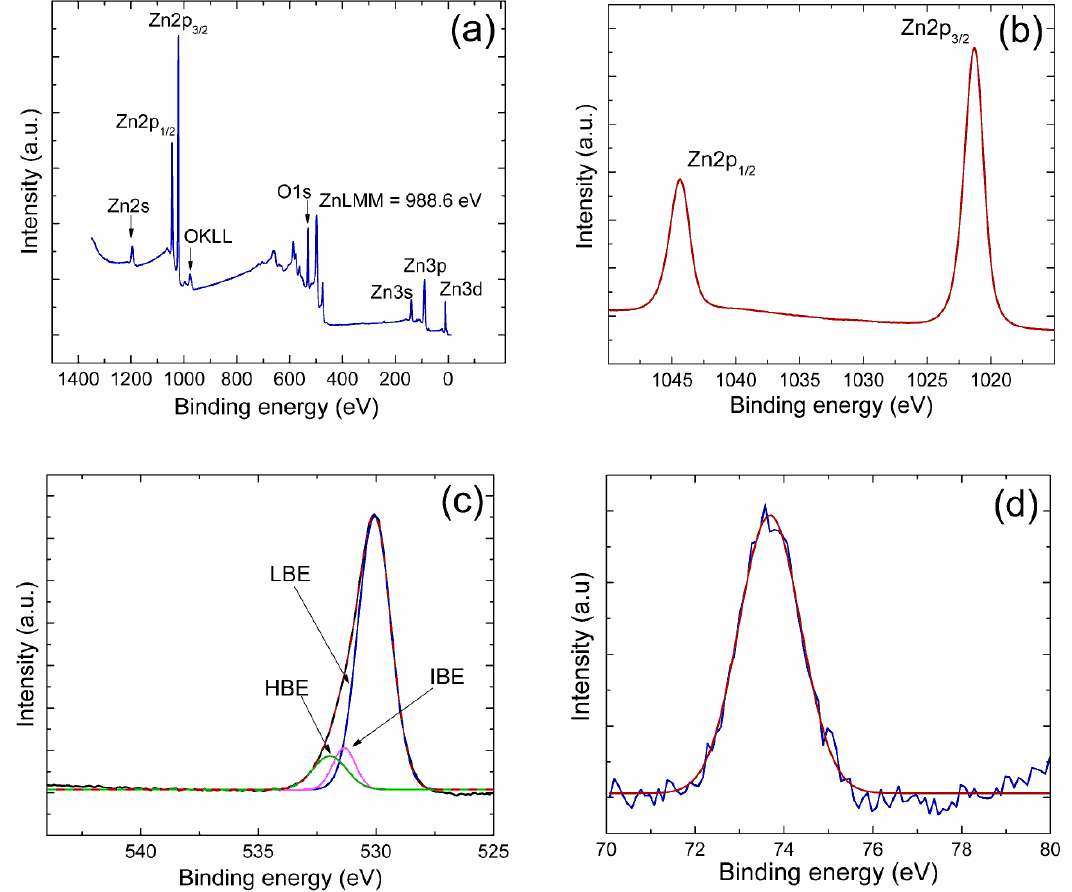
Figure 2. XPS measurements corresponding to the coating of sample 1 after sputtering: ( a ) survey spectrum; ( b ) Zn2p, ( c ) O1s, and ( d ) Al2p high resolution window spectra.